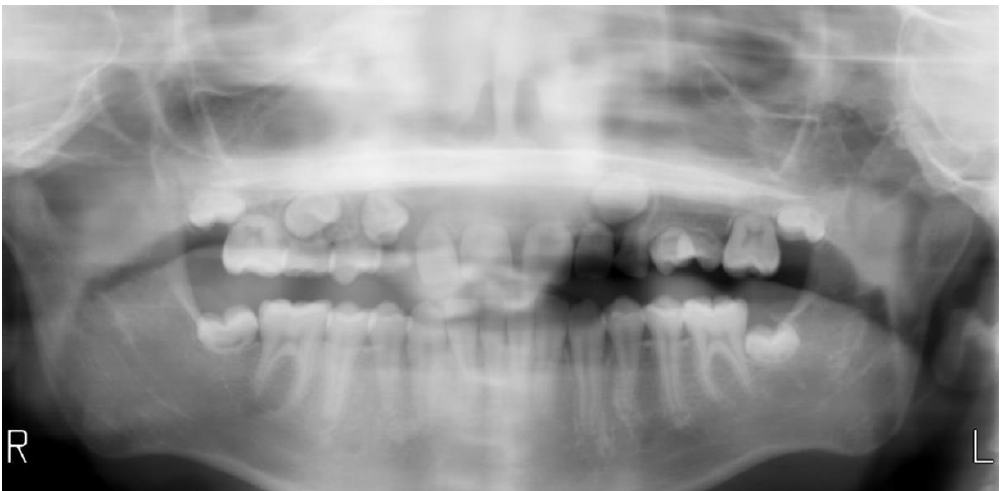
Figure 2. Panoramic x-ray.